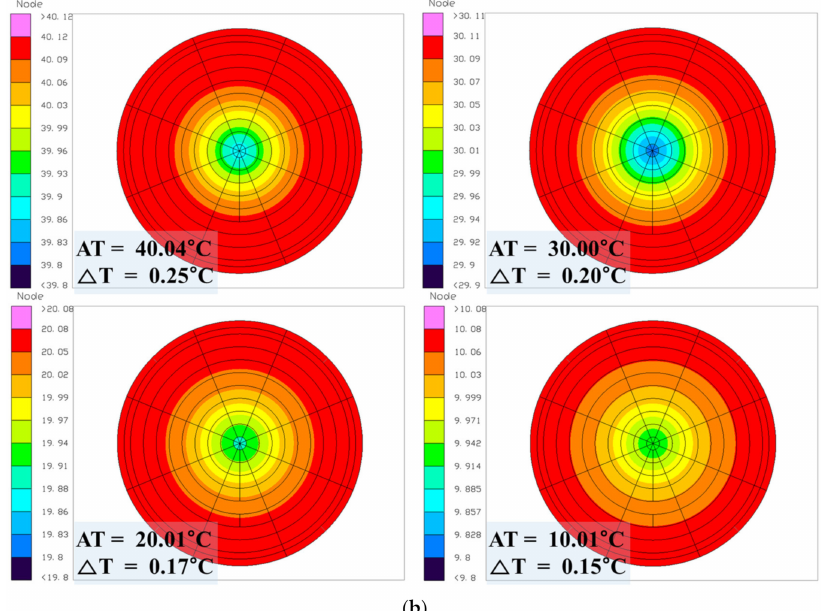
Figure 8. Temperature distribution on BB surface in cooling range at heat pipe normal operation con- dition. ( a ) Worst hot case; ( b ) worst cold case; AT: average temperature of BB surface; ∆ T: temperature gradient on BB